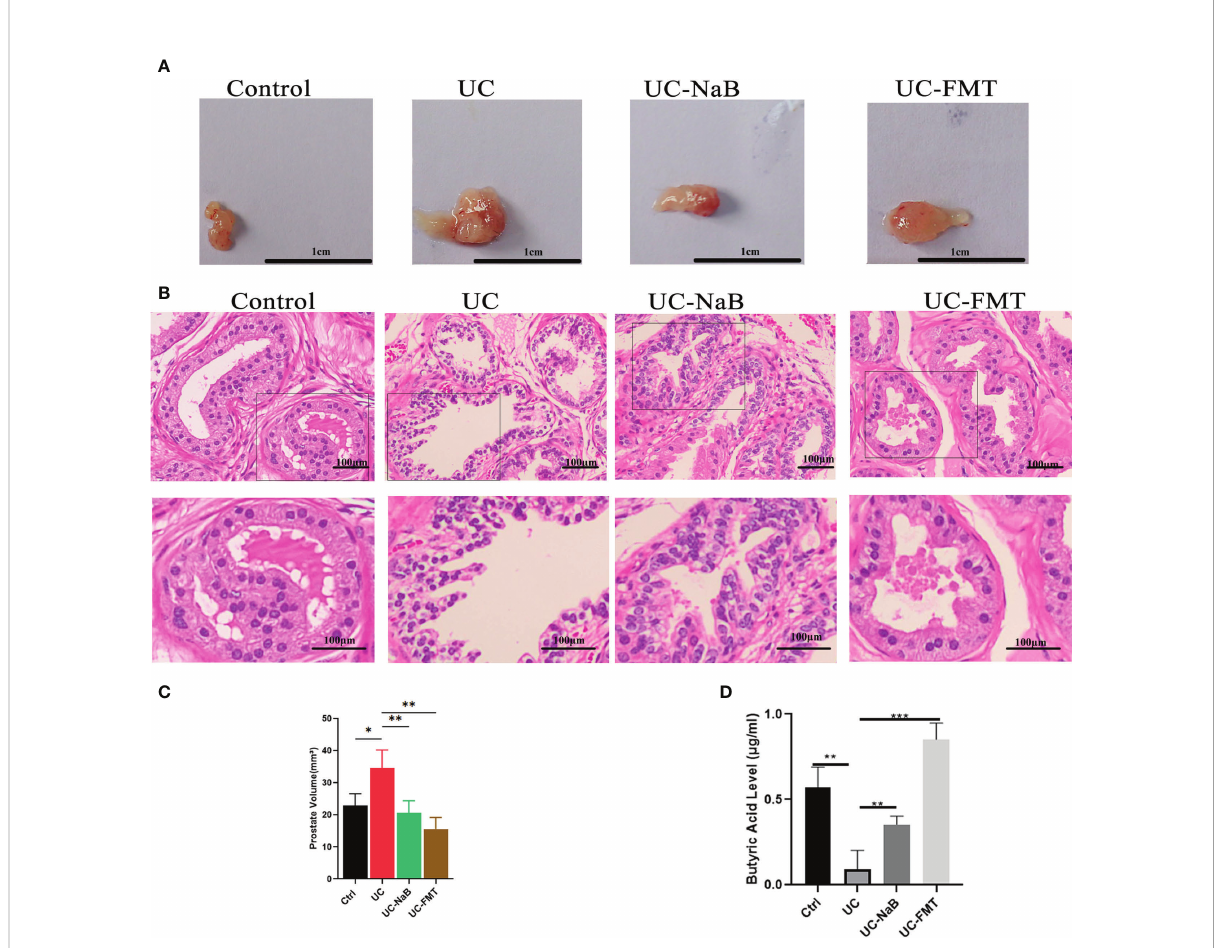
FIGURE 2 Pathological model of the prostate in the mouse. (A) Anatomical map of the prostate. (B) Histopathological images of HE staining of the prostate glands. Histopathological images of HE staining (B) and volume (C) of the prostate glands. (D) The levels of butyric acid in prostate gland. * p <0.05, ** p <0.01, *** p